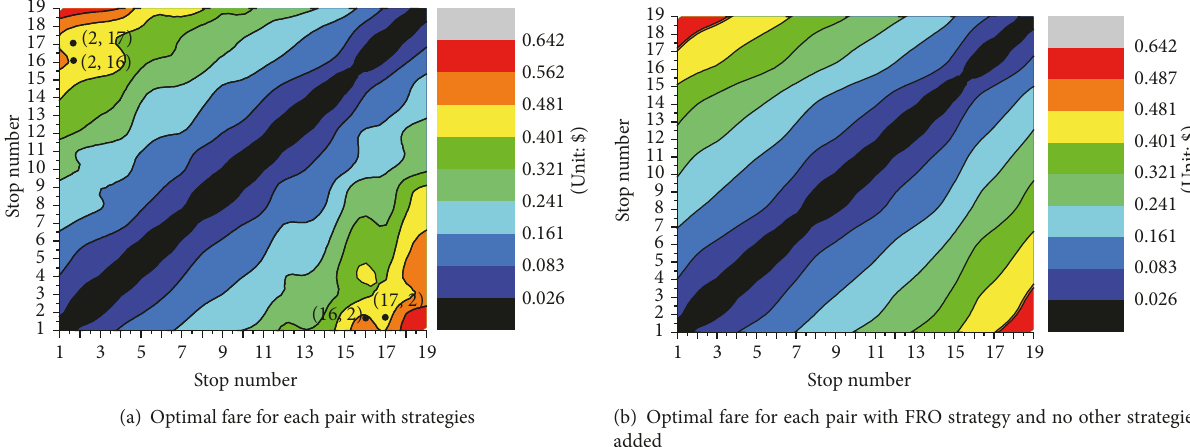
Figure 4: Optimal fares for each pair along a bidirectional bus line with and without use of